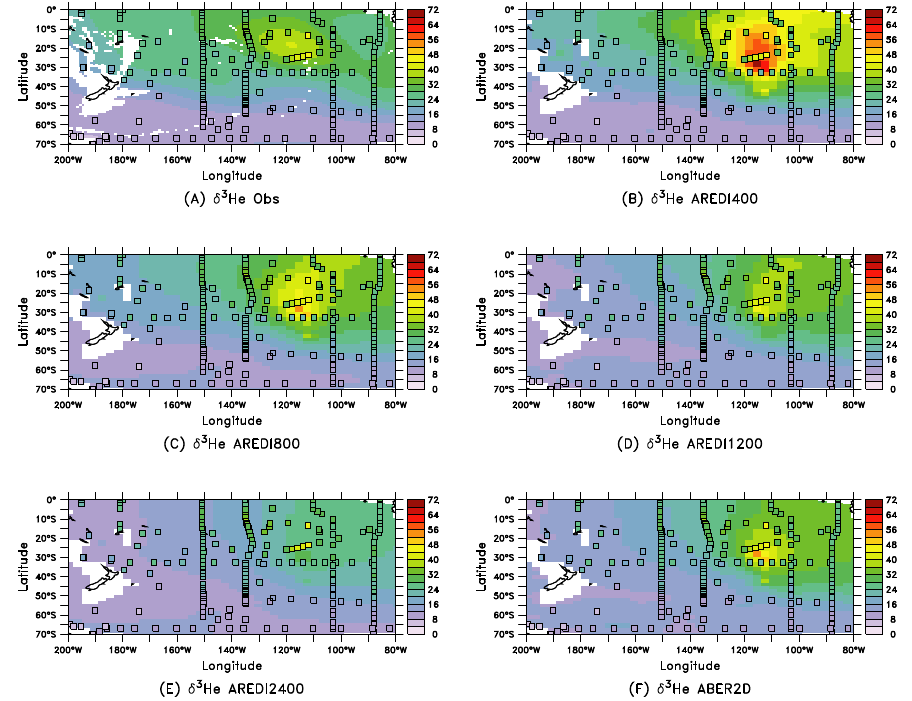
Figure 9. δ 3 He (in %) in the SE Pacific between the depths of 2250 and 2750m. Symbols are taken from observational data set of Bianchi et al. (2010). (a) Gridded data set of Bianchi et al. (2010) showing effects of smoothing. (b) AREDI400. (c) AREDI800. (d) AREDI1200. (e) AREDI2400. (f) ABER2D.